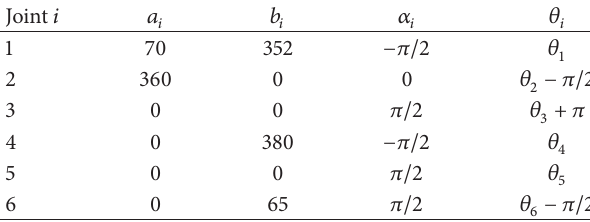
Table 1: D-H parameters for the